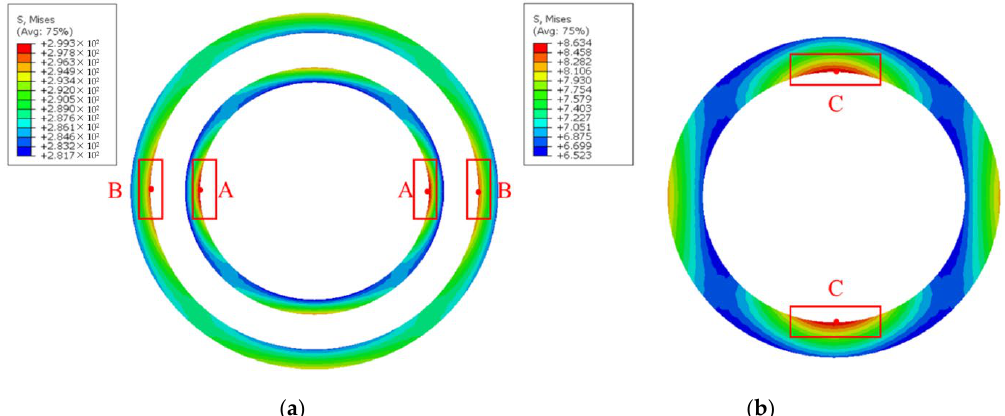
Figure 14. The von Mises stress distribution of pipes’ cross-sections. ( a ) Outer and inner pipes’ cross-section; ( b ) core layer cross-section.